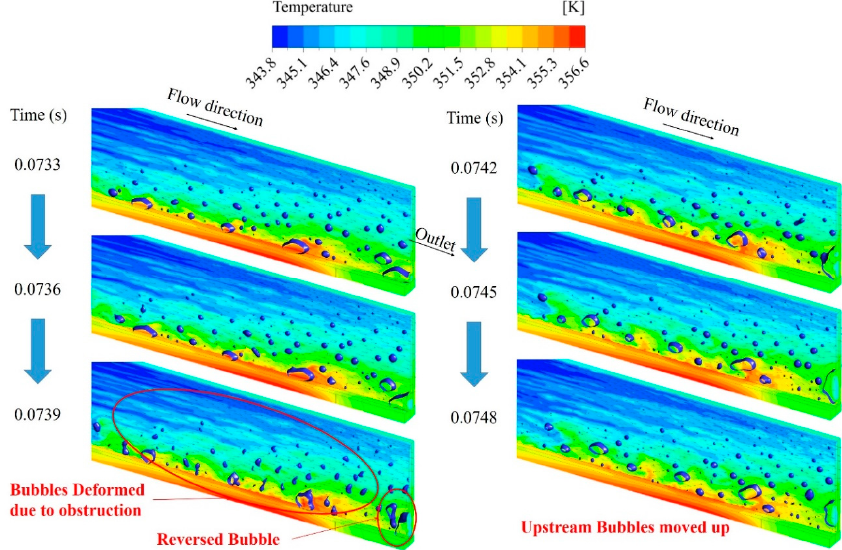
Figure 12. Transient temperature distribution and two-phase flow pattern at G = 700 kg/(m 2 ·s) for the cross-section of 0.2 × 2.0 mm. Energies 2020 , 13 , x FOR PEER REVIEW 15 of 22